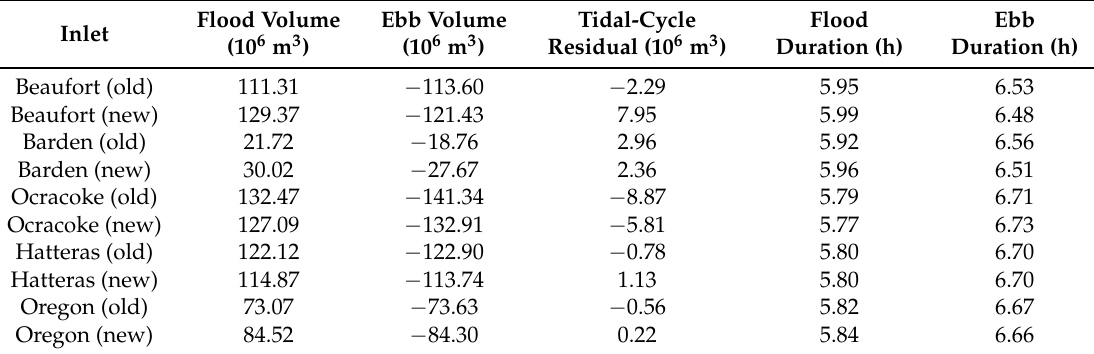
Table 3. Flood and ebb volumes and durations across five North Carolina inlets from the old-bathy model and the new-bathy